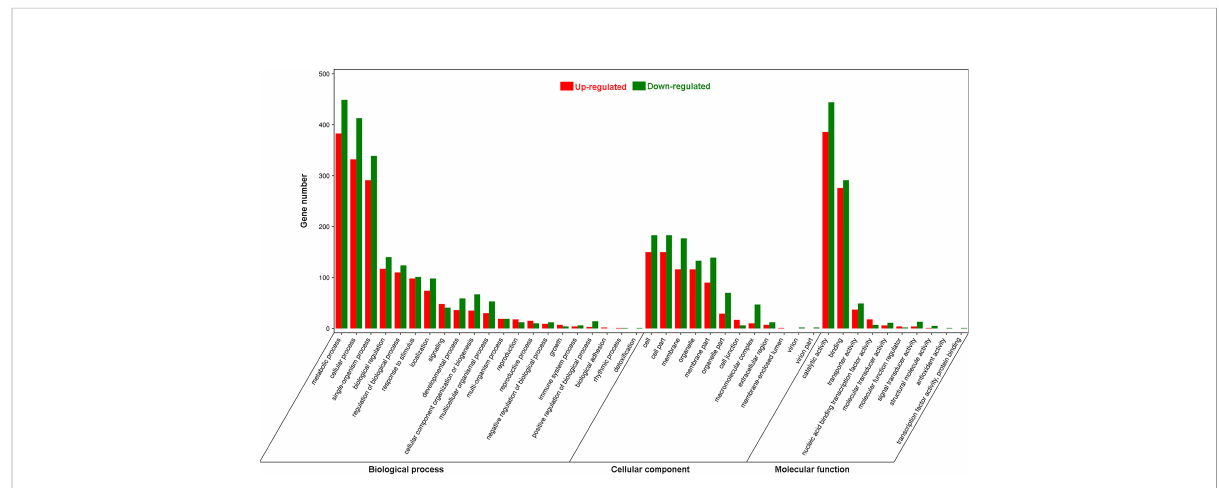
FIGURE 1 Gene Ontology (GO) analysis of differentially expressed genes (DEGs) in Pyrus betuleafolia leaves after Spodoptera litura